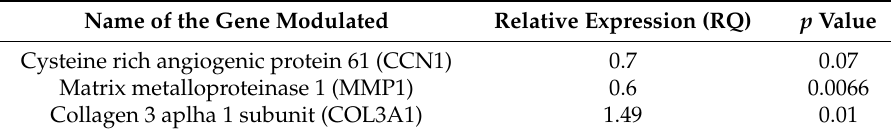
Table 3. Genes modulated in fibroblasts when treated for 24 h with N- at 0.2%. The relative expression (RQ) of each gene was calculated in comparison to fibroblasts treated with the vehicle dimethyl sulfoxide (DMSO) at 1%. Name of the Gene